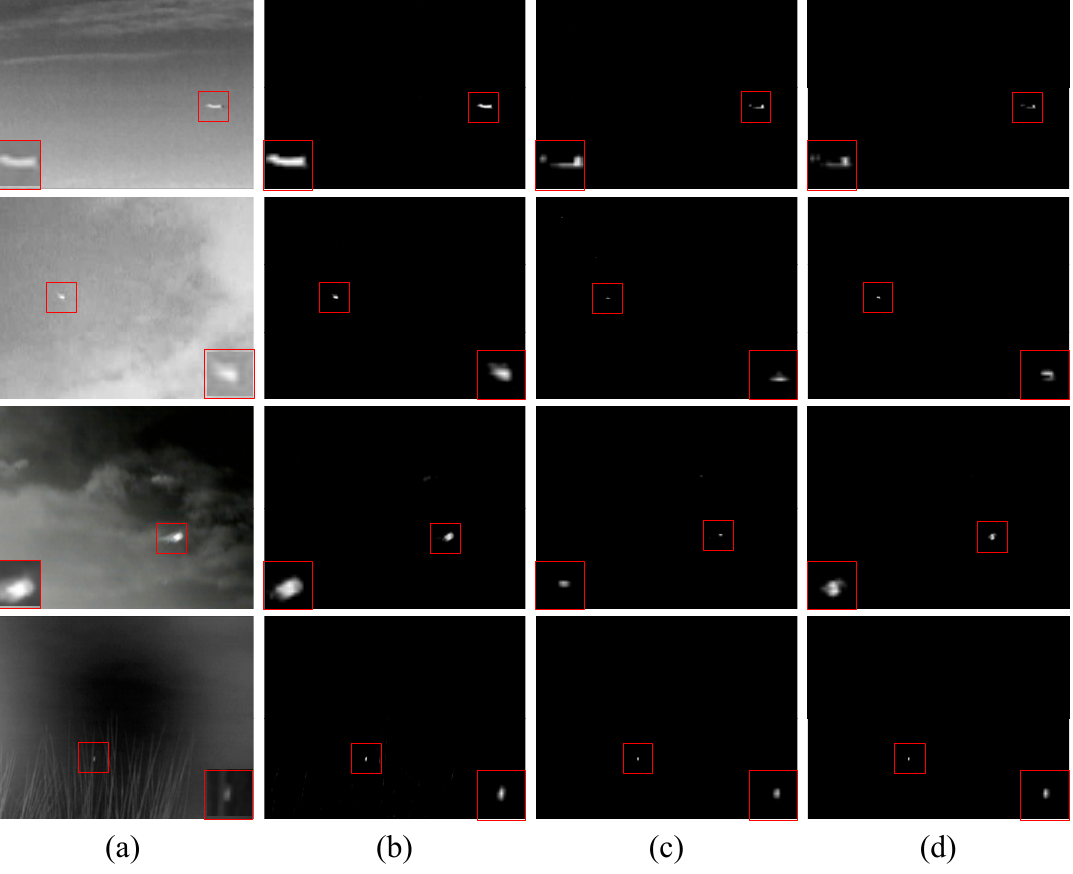
Figure 8. Comparison of IPI NOSLC and NOLC. ( a ) Original images; ( b ) IPI processing result; ( c ) NOSLC processing result; ( d ) NOLC processing result.